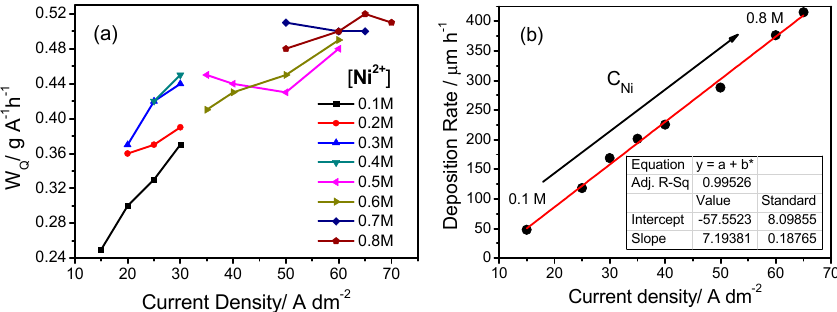
Figure 3. ( a ) The relationships between W Q (Fe–Ni alloy weight electrodeposited for 1 A · h, 1 A · h = 3600 C) and current density, ( b ) the relationship of deposition rate and current density.